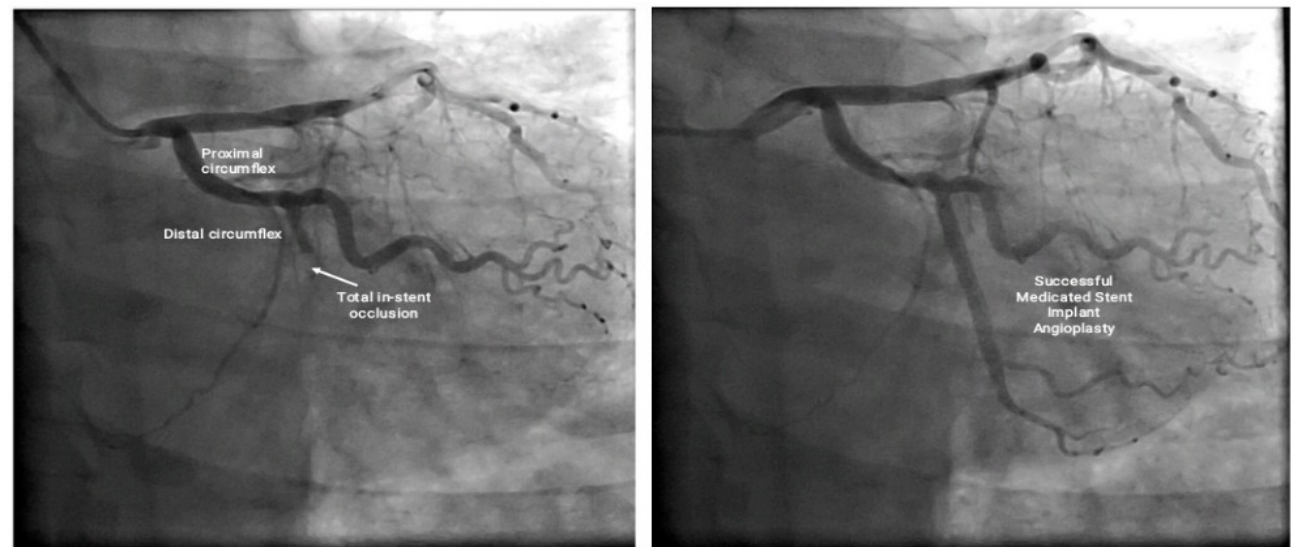
Figure 2. Coronary arteriography showing complete thrombotic stent occlusion in the circumflex artery ( left ), and successful posterior placement of a medicated stent in the circumflex artery ( right ) .